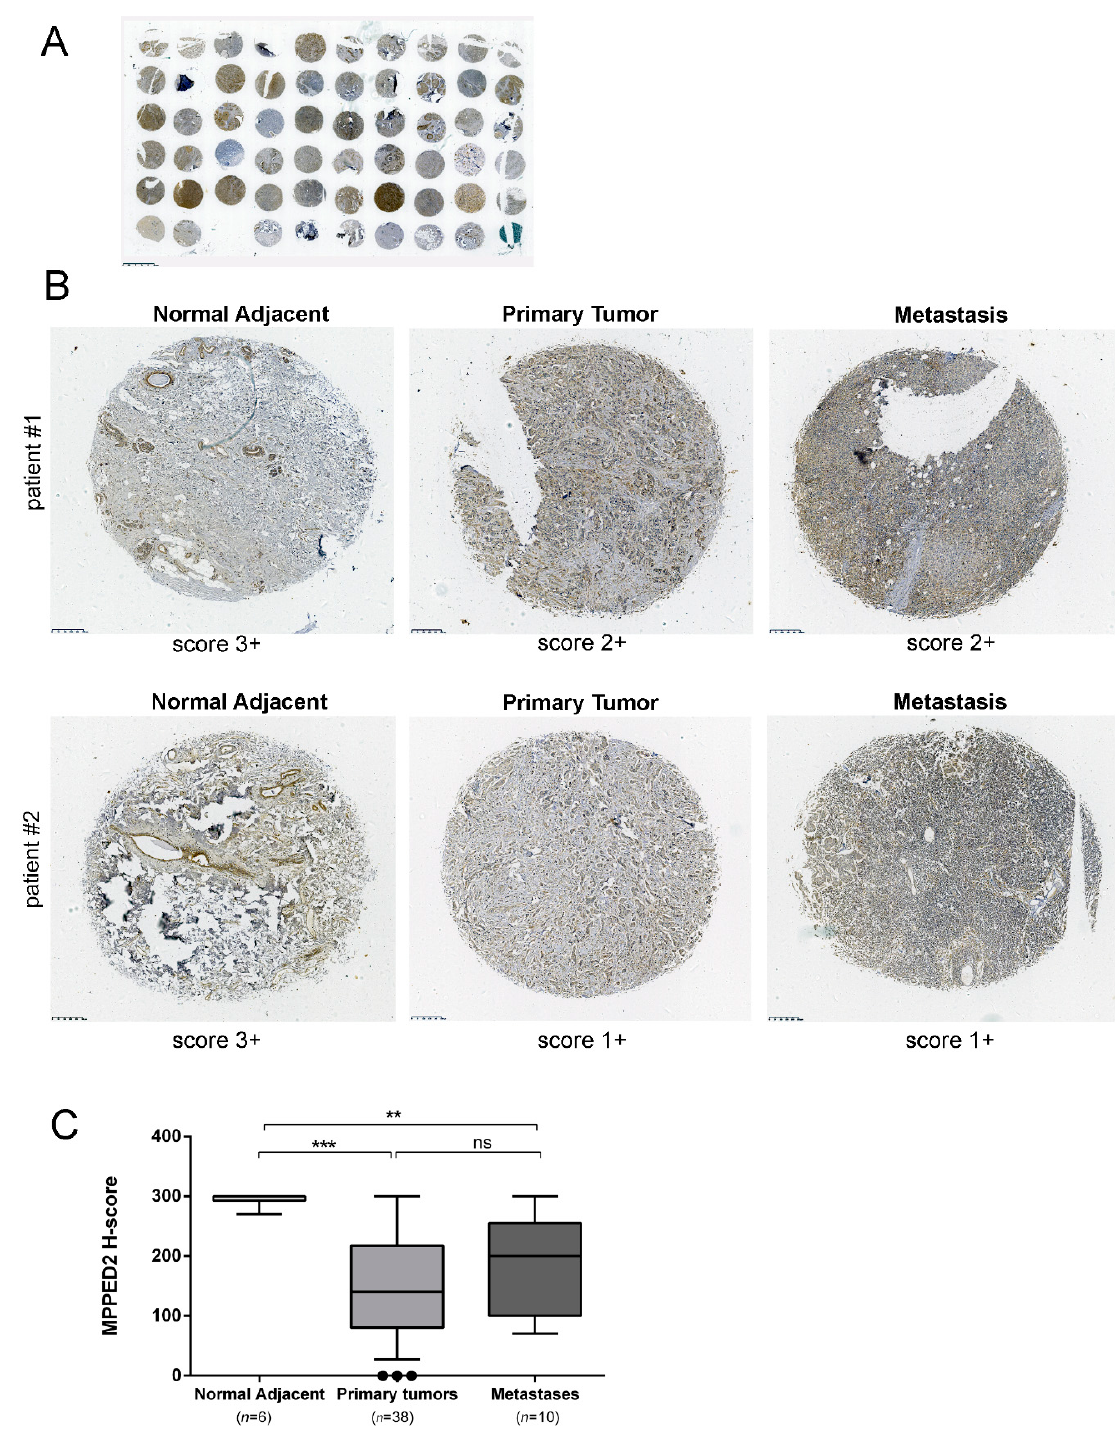
Figure 2. MPPED2 protein expression in human breast carcinoma tissues. ( A ) Gross view of immunohistochemical staining of a tissue microarray (TMA) slide. Scale bar, 2.5 mm. ( B ) Representative immunohistochemical staining of MPPED2 protein in normal adjacent tissue (left), breast primary tumor (center) and metastatic tissue (right) derived from two different patients (upper and lower panel), respectively. MPPED2 signal is strong in normal adjacent tissue (score 3+) and moderate (score 2+) or weak (score 1+) in primary tumor or metastatic tissues (magnification 200×). Scale bar, 250 µm. ( C ) Intensity of the staining and the percentage of positive cells were combined to obtained H-score. Box and whiskers: 10–90 percentile; Mann–Whitney test: ***, p < 0.001 (primary tumor vs. normal adjacent); **, p < 0.01 (metastasis vs. normal adjacent); ns, not significant (primary tumor vs. metastasis).